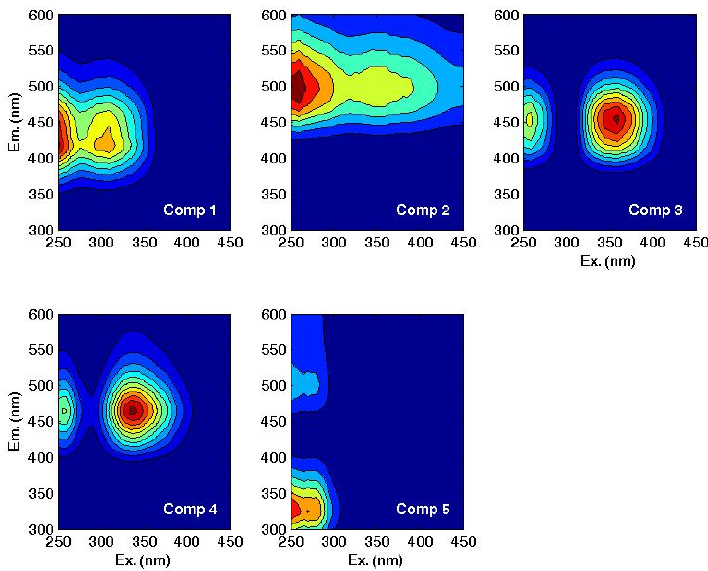
Figure 5. Characteristic EEMs of all five modeled PARAFAC components. For further component description see Sect.